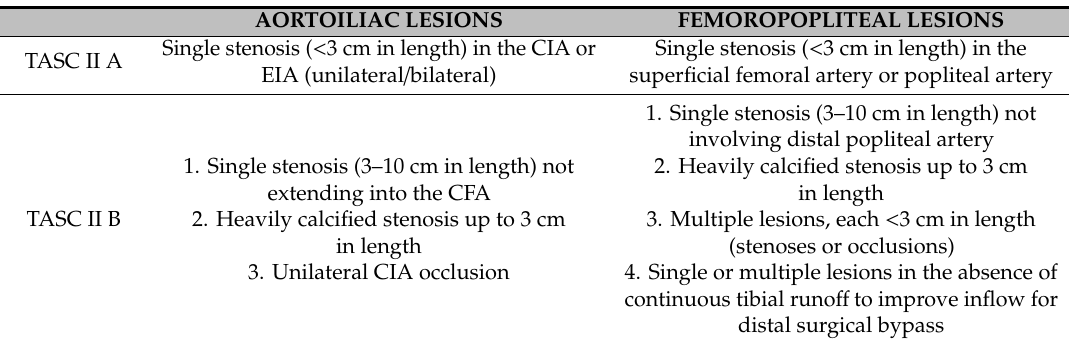
Table 1. TASC II classification for the assessment of severity and complexity of peripheral vascular diseases